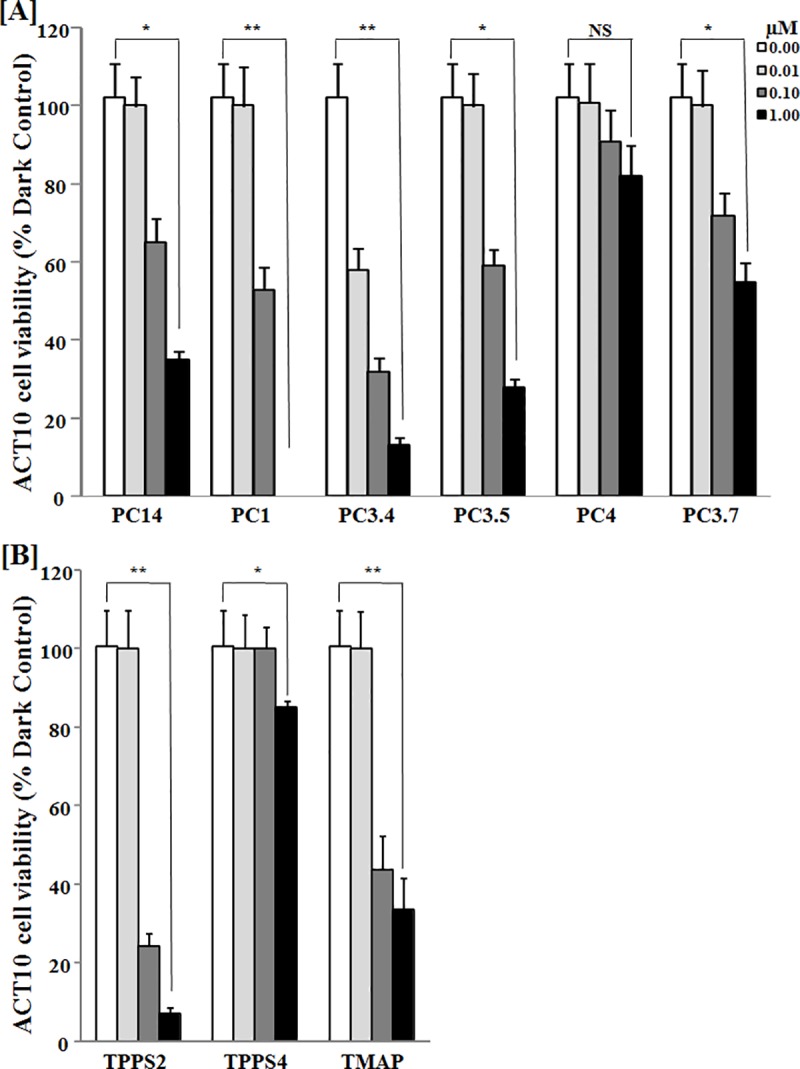
MTT reduction assays of Aedes cells for their viability in vitro, showing phthalocyanine [A] and porphyrin [B] concentration-dependent photo-inactivation. See Materials and Methods for experimental details. Briefly, Monolayers of ACT10 cells were exposed overnight in the dark to 0, 0.01, 0.1 and 1 uM photosensitizers (PS), as indicated in the legend of the graph. For each concentration of every PS used, one set was kept in the dark and the other set exposed to light. After further incubation overnight, all cell samples were processed in triplicate for the MTT reduction assay, as described. Cell viability is presented as % control by normalizing the values from light-exposed samples against those of the dark controls for each set of PS at all concentrations used. Data are presented for each PS in 4 bars with increasing shades of darkness, representing increasing PS concentrations from 0 to 1 uM, as indicated. Note: the PS concentration-dependent loss of cell viability by photo-inactivation in all cases. NS, Not significant; *, p = 0.01–0.05; ** p = 0.01–0.001.